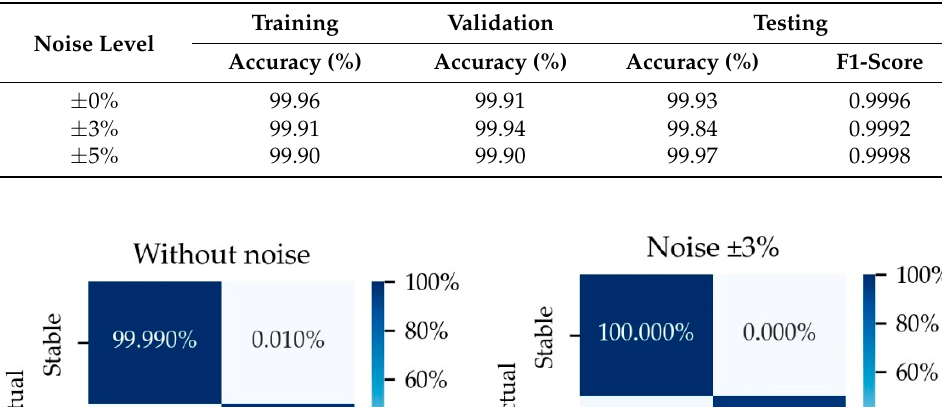
Table 6. Recapitulation of test results for the effect of noisy data.